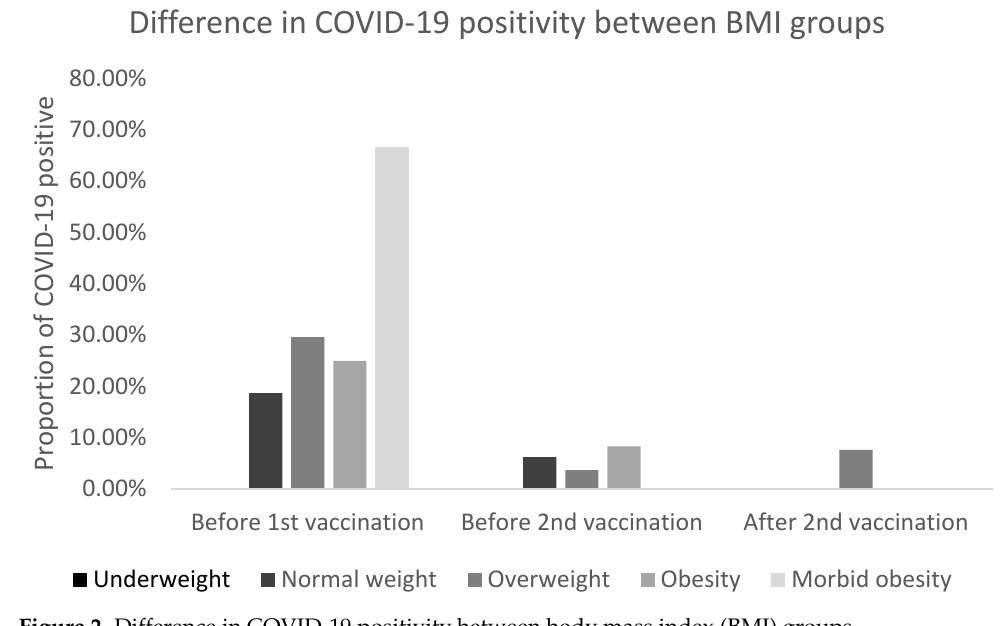
Figure 3. Number of adverse events by gender. □ mean ± standard deviation; ◊ median; │ mini- mum − maximum. Table 3. Two-sided p -values for difference in adverse events between body mass index (BMI) groups. Underweight Normal Weight Overweight Obesity Morbid Obesity